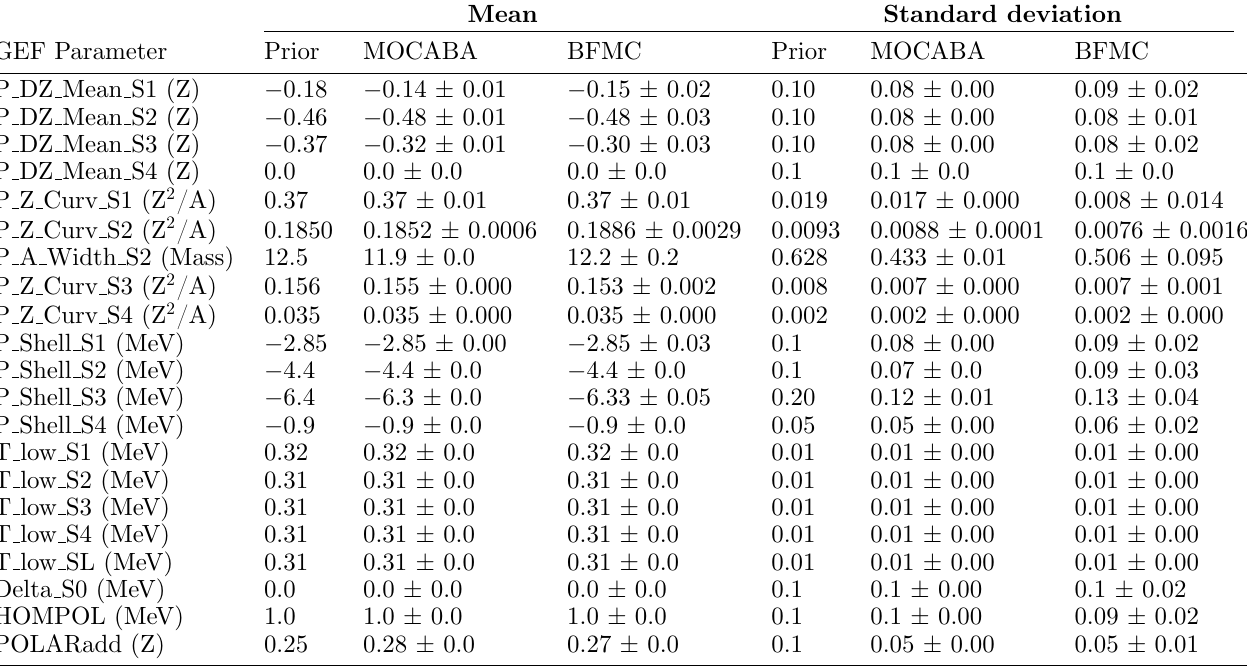
Table 2. Prior and posterior means and standard deviations of GEF’s model parameters, shown with 95% confidence intervals that were estimated with bootstrap sampling.